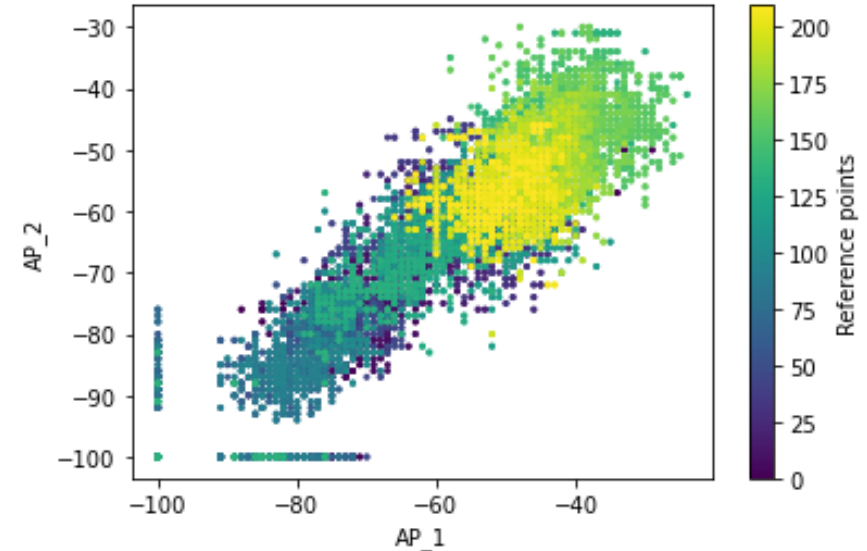
Figure 9. Distributions of RSS for Pair Wi-Fi APs of 1 and 2 for dataset A.